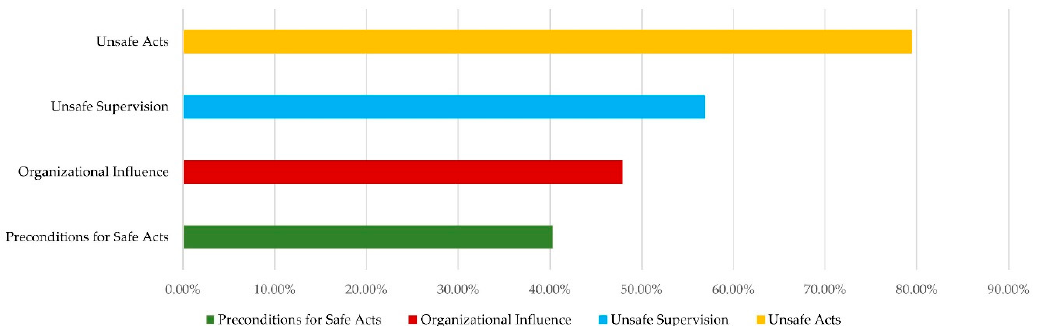
Figure 8. Marginal probability distribution by different levels.